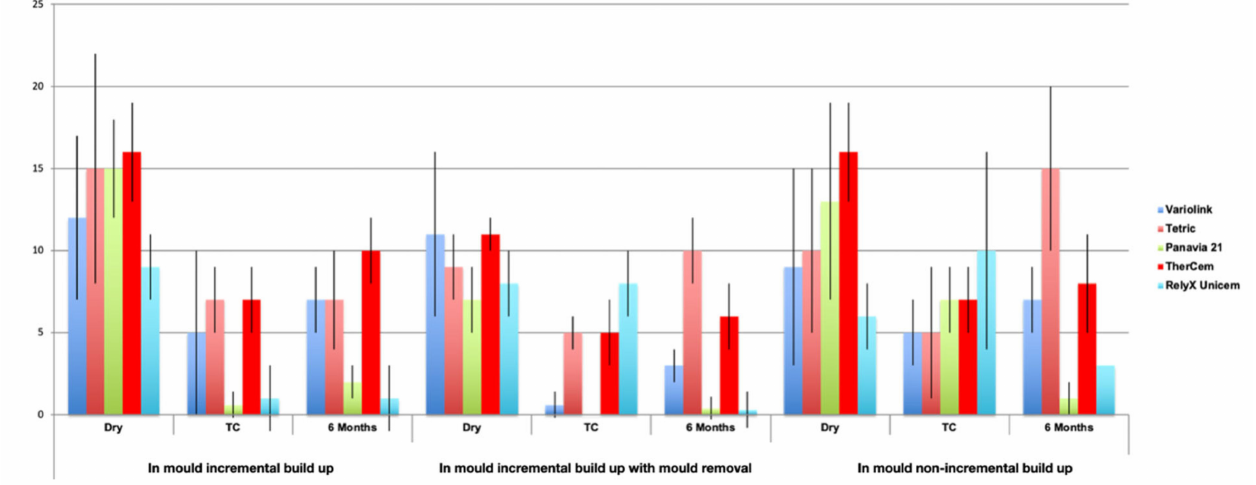
Figure 3. Mean and standard deviation values (MPa) for the 5 cements (Variolink, Tetric, Panavia 21, TheraCem and RelyX Unicem) for the 3 protocols and ageing methods (dry, thermocycling and 6 months of water